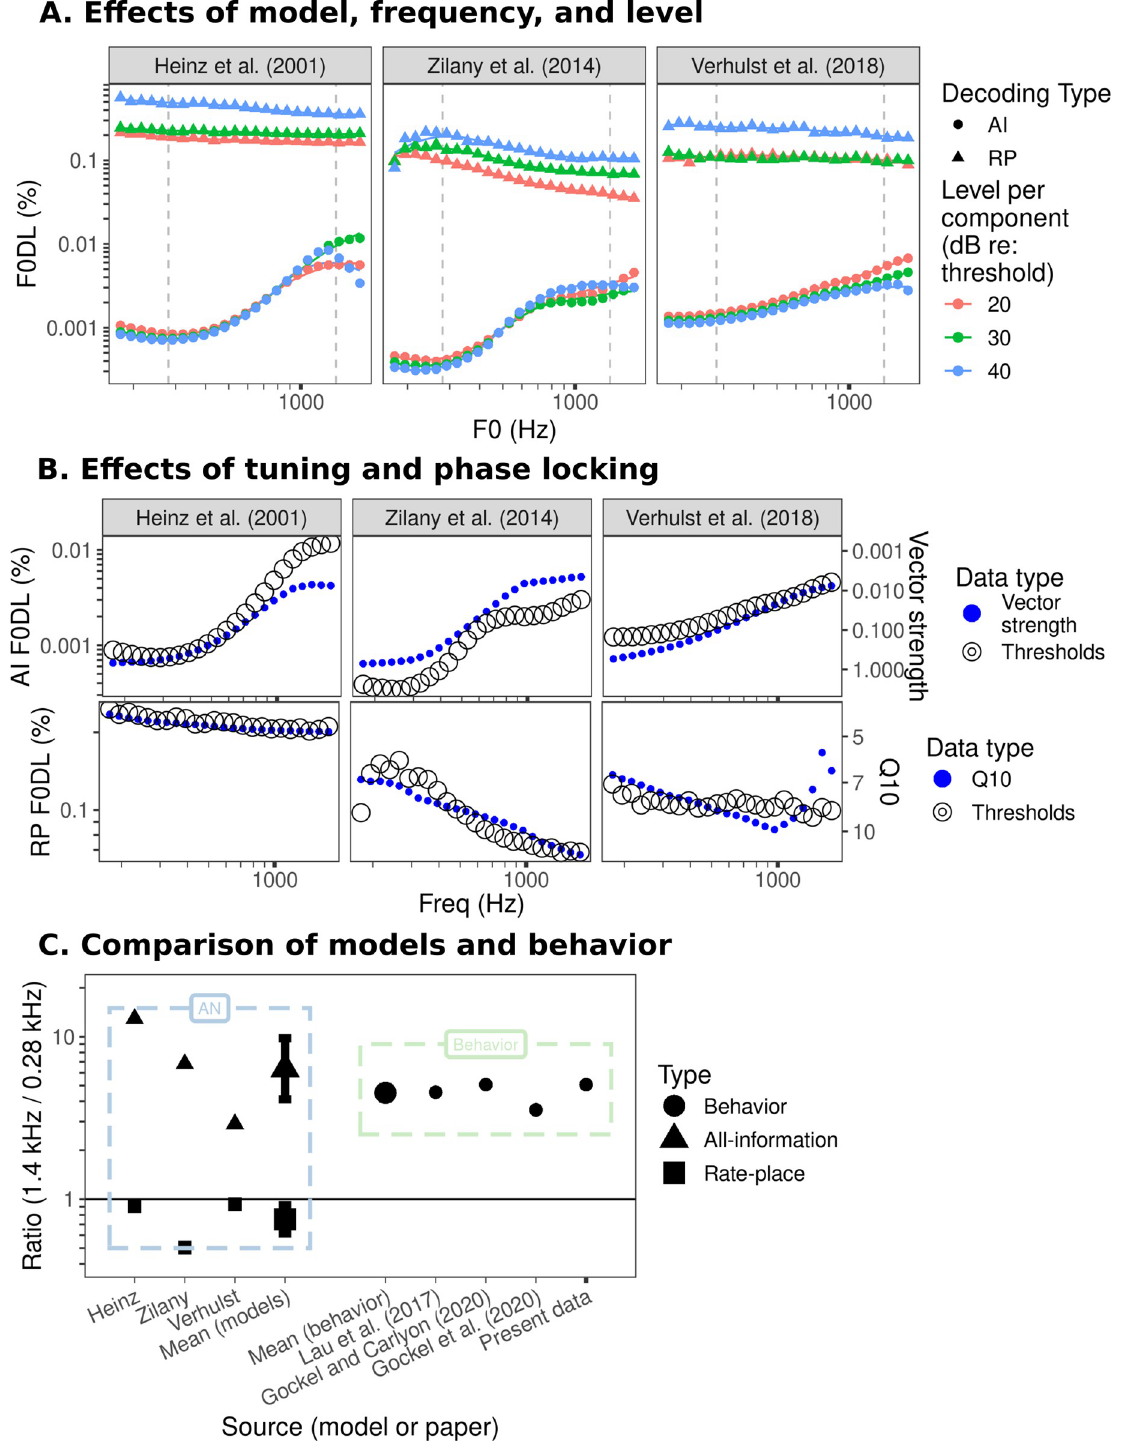
Fig 8. Ideal-observer predictions for F0 discrimination. Results of the F0 discrimination simulations. (A) Simulated F0DLs versus F0 of the ISO HCT stimulus in each auditory-nerve model. Simulations in this panel include no parameter roving. Points indicate the simulated F0DLs at a particular F0 while lines indicate a locally estimated scatterplot smoothing (LOESS) fit to the simulated F0DLs. (B) Simulated all-information F0DLs and vector strength (top row) and simulated rate-place F0DLs and Q10 (bottom row) versus frequency with a double y-axis. To choose the warping on the y-axis for vector strength and Q10, linear models were fit to predict log-transformed F0DLs as